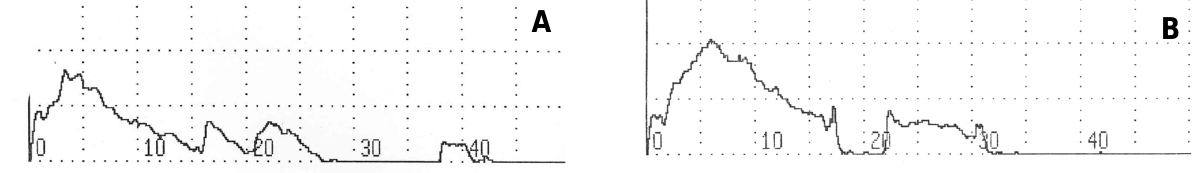
Figure 5 – Improved urinary flow of both boys after 6 months of treatment with terazosine; 7 year-old boy (A) and 11 year-old boy (B).